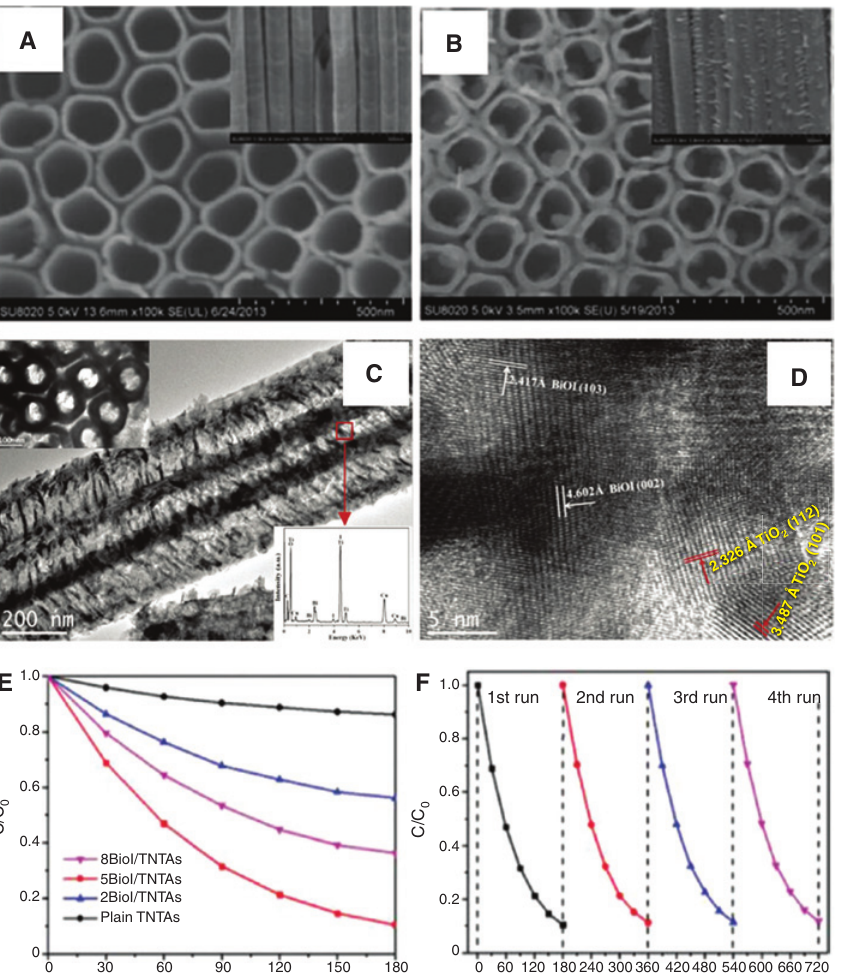
NTAs (A) and BiOI/TiO NTAs with repeated times for five cycles (B). Insets (A), (B) are the side view images Figure 14: SEM images of TiO 2 2 counterparts. TEM and HRTEM images of BiOI/TiO NTAs. Inset (C) is the EDX spectra. Photoelectrocatalytic degradation rate of MO of TiO 2 NTAs and BiOI/TiO NTAs with different repeated deposition times (E). Cycling degradation curve of BiOI/TiO 2 Reproduced from Ref. [185] with permission. Copyright Royal Society of Chemistry